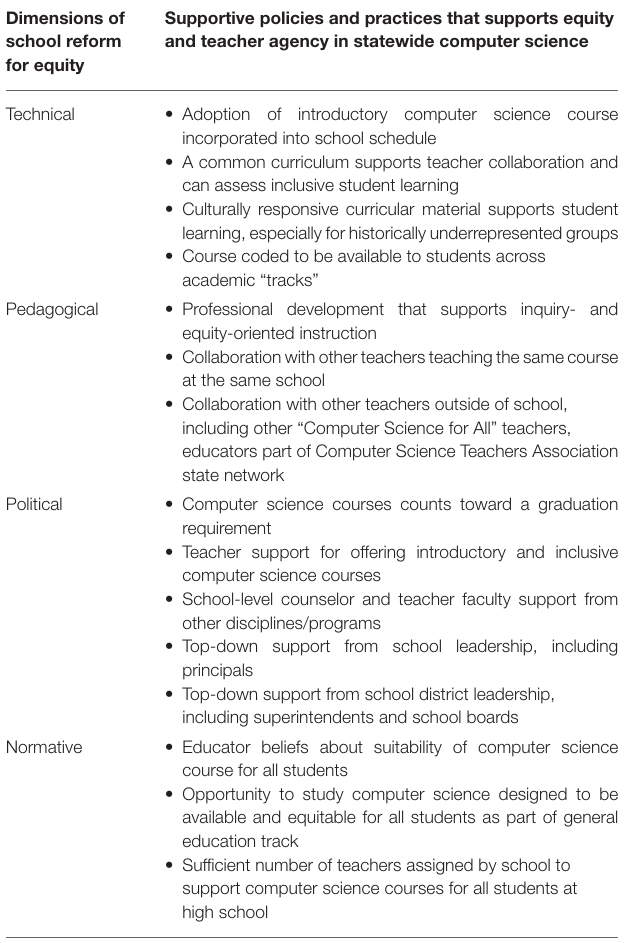
TABLE 2 | Developing equity-focused practices for computer science school